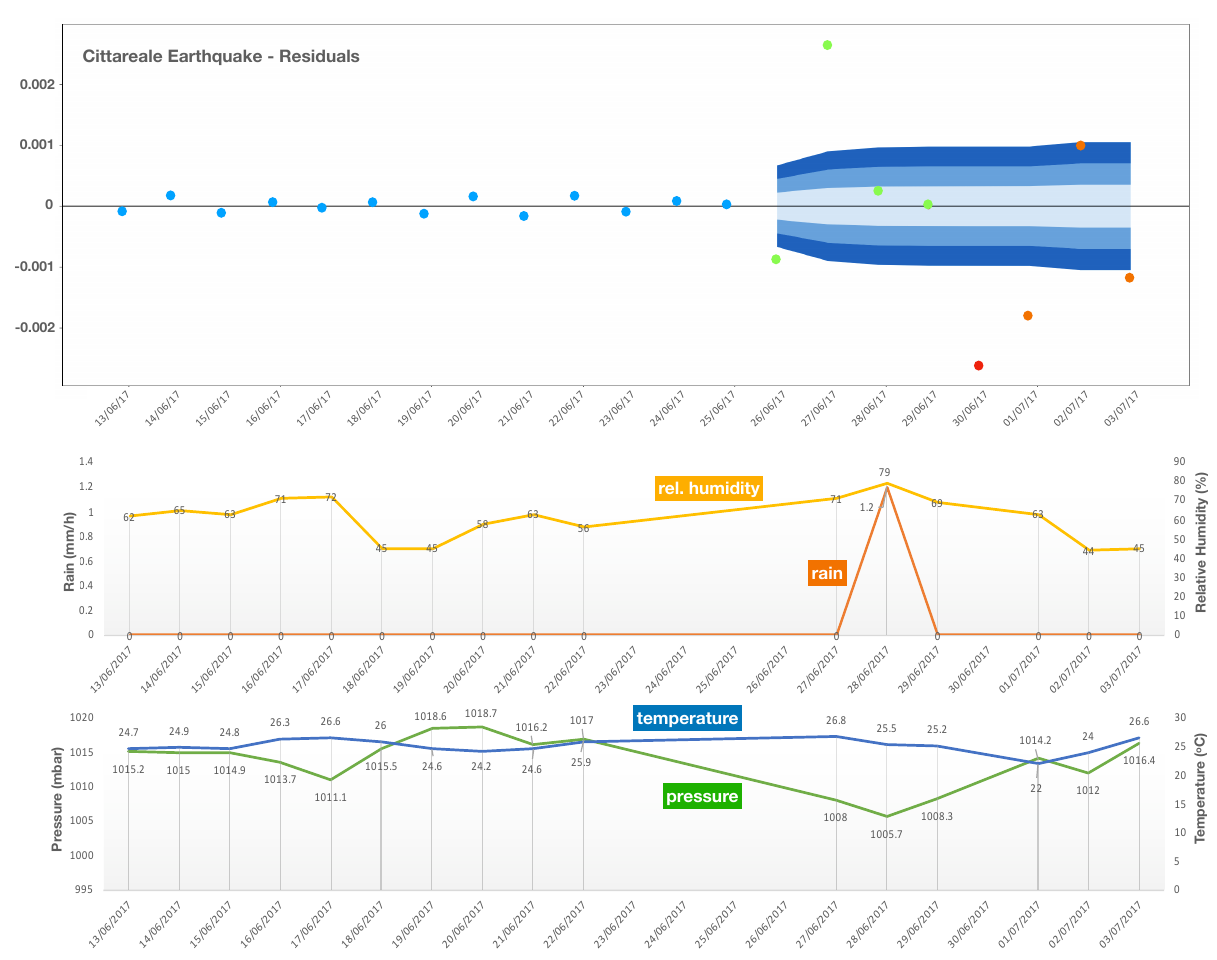
Figure 9. Cittareale earthquake (color on-line)—upper panel: residuals of the model. Blue points correspond to the dose rate background data and green points to the pre-shock events; the red point is the earthquake event and the orange points represent aftershock events. The confidence level bands for coverage factor k = 1, 2, 3 (from the lightest to the darkest blue) are drawn in the blind time region. In the middle and lower panels the relative humidity, rainfall, temperature, and pressure time series are shown, as indicated by the respective